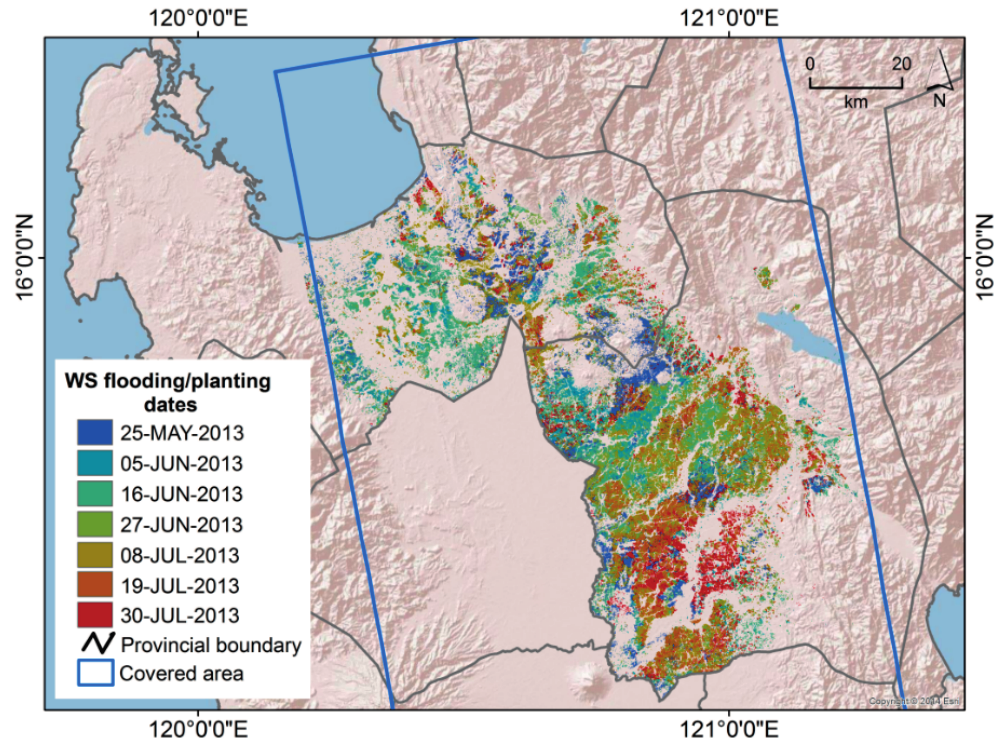
Figure 8. Flooding/transplanting dates within the rice areas during WS 2013 generated from TSX ScanSAR multitemporal